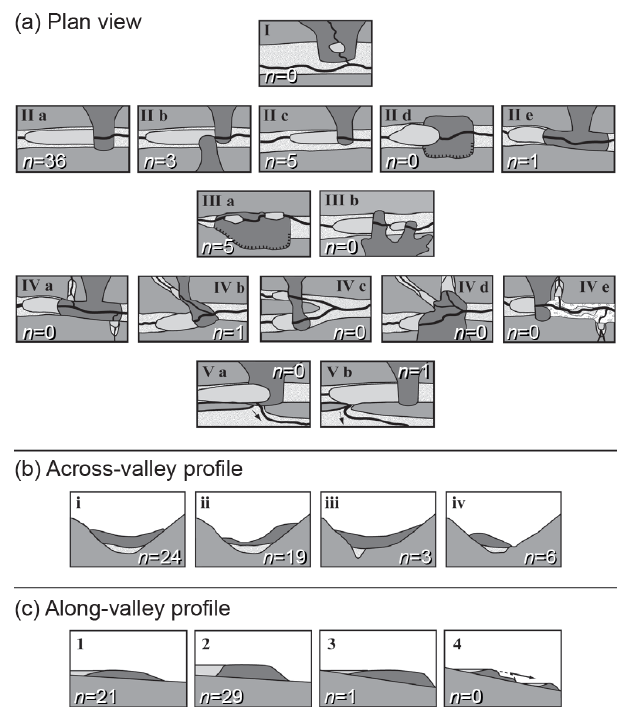
Figure 3. Morphologic classification of landslide dams (modified from Hermanns et al., 2011b) with count of landslide dams in south- western Norway: (a) in plan view, dams formed by a landslide com- pletely crossing the valley (type IIa) are most common, followed by partial damming of the valley (type IIc) and landslide dams hav- ing multiple lakes (type IIIa); (b) in the across-valley profile, most dams are symmetrical deposits in a symmetrical valley (type i) or asymmetrical with the thickest deposits in the distal part (type ii); (c) in the along-valley profile, dams with low thickness and gentle slopes (type 1) and dams with high thickness and steep slope (type 2) are most